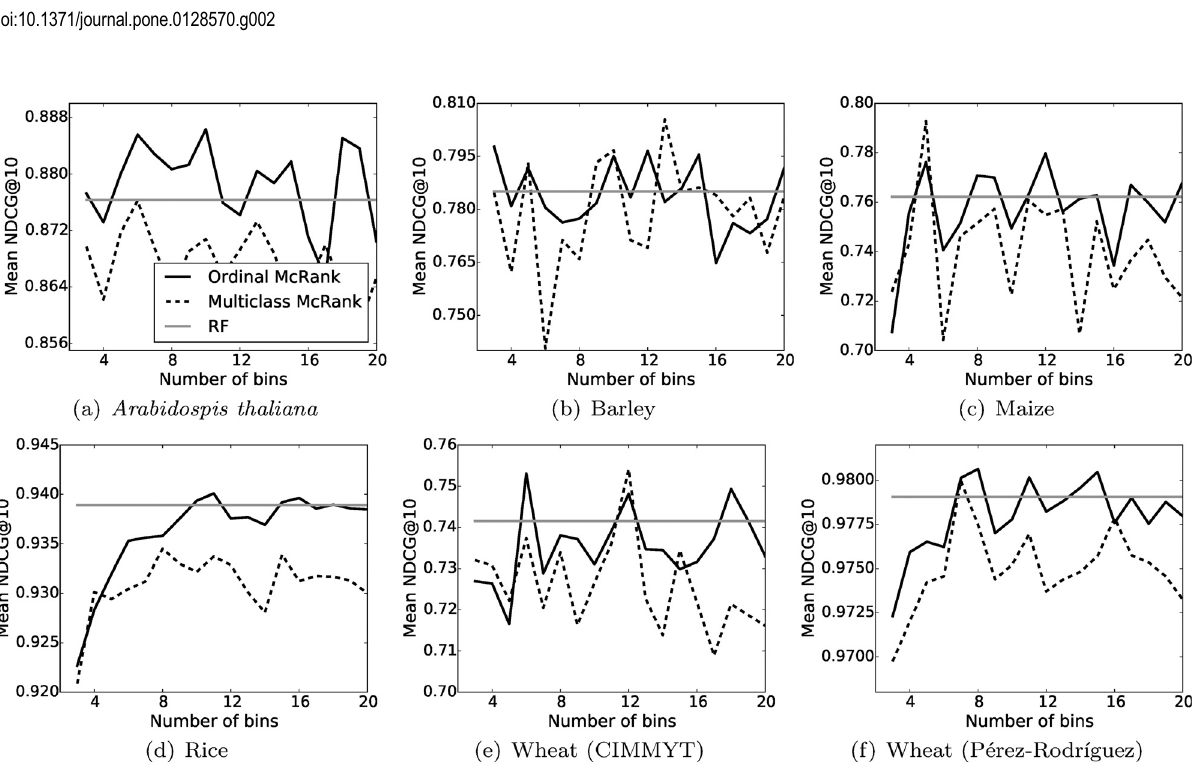
Fig 3. Effect of the number of bins on multiclass and ordinal McRank. The straight line indicates the results of RF for comparison. The scores indicated are the test Mean NDCG@10 averaged over 10 CV iterations and across all traits.